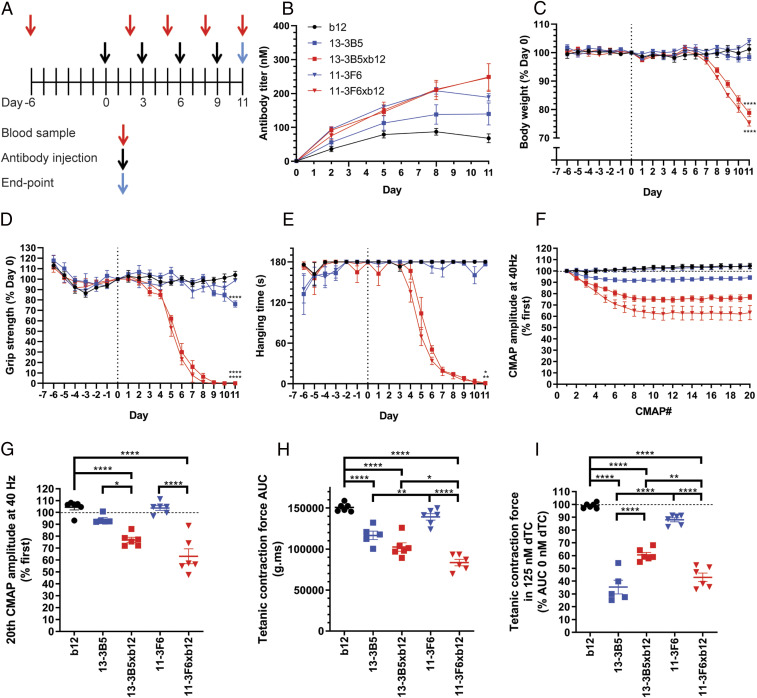
Monovalent MuSK antibodies induce rapid onset, progressive myasthenic symptoms in mice, whereas bivalent MuSK antibodies do not. (A) Experimental design of passive transfer with 2.5 mg/kg recombinant antibody. (B) Serum antibody titers confirmed exposure. (C–E) Monovalent, but not bivalent, MuSK antibodies induced progressive weight loss and muscle weakness. Bivalent 13–3B5 induced a delayed, mild loss of grip strength. (F and G) Monovalent, but not bivalent, MuSK antibodies induced a significantly larger CMAP decrement upon repetitive stimulation at 40 Hz compared with the b12 control. (H) Ex vivo tetanic contraction force of the diaphragm was reduced by 13–3B5, 13–3B5xb12, and 11–3F6xb12 compared with b12. (I) The safety factor of neuromuscular transmission was assessed in the presence of 125 nM dTC. Exposure to all MuSK antibodies reduced the safety factor compared with the b12 control, although for 11–3F6 this was only a trend (P = 0.079). 11–3F6 and 11–3F6xb12: n = 6; 13–3B5: n = 5; 13–3B5xb12 and b12: n = 6 (hanging time n = 5). Data represent mean ± SEM. One-way ANOVA with Šidák-corrected comparisons for all parameters (C, D, G, H, and I) except hanging time, for which Kruskal–Wallis test was used (C). *P < 0.05, **P < 0.01, *** <0.001, ****P < 0.0001 compared with b12 group, unless otherwise specified.